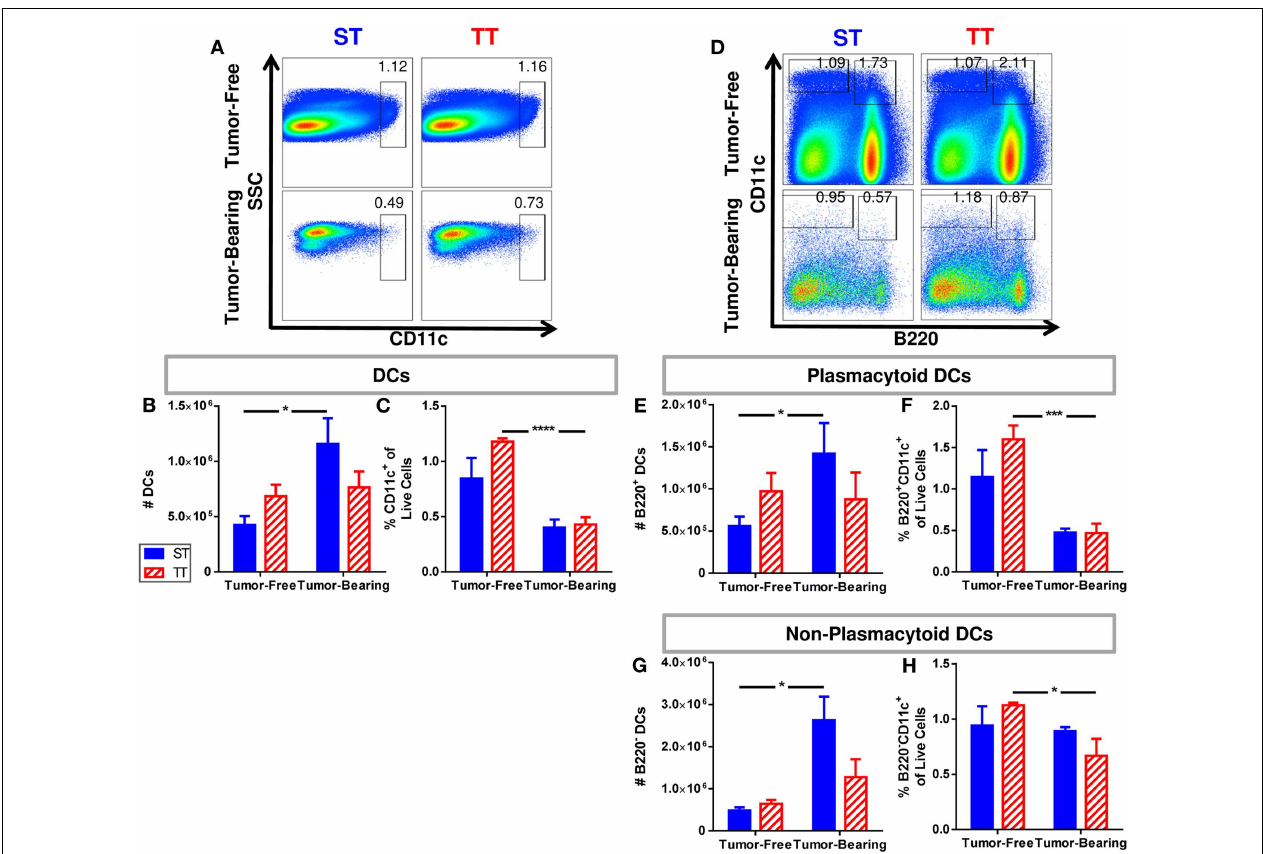
strategy used to select B220 + CD11c + and B220 − CD11c + cells. Percentage of cells are shown above their respective gate. (E) The absolute number of B220 + CD11c + cells calculated from the total number of splenocytes counted in each individual mouse. (F) The percentage of B220 + CD11c + cells of the total population of live cells as determined by DAPI staining. (G) The absolute number of B220 − CD11c + cells calculated from the total number of splenocytes counted in each individual mouse. (H) The percentage of B220 − CD11c + cells of the total population of live cells as determined by DAPI staining. Data presented as mean ± SEM; n = 5/group; Student’s t -test; * p < 0.05, *** p < 0.001, **** p <